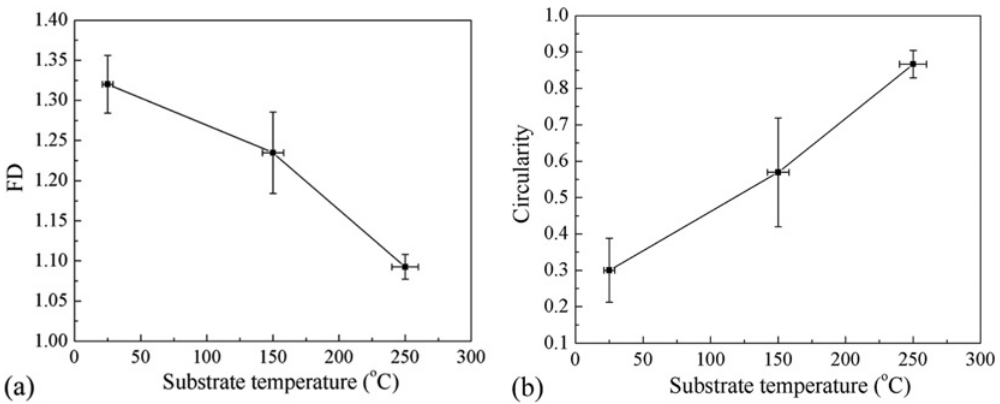
Figure 2: The changes in the FD (a) and the circularity (b) of the splats with the substrate